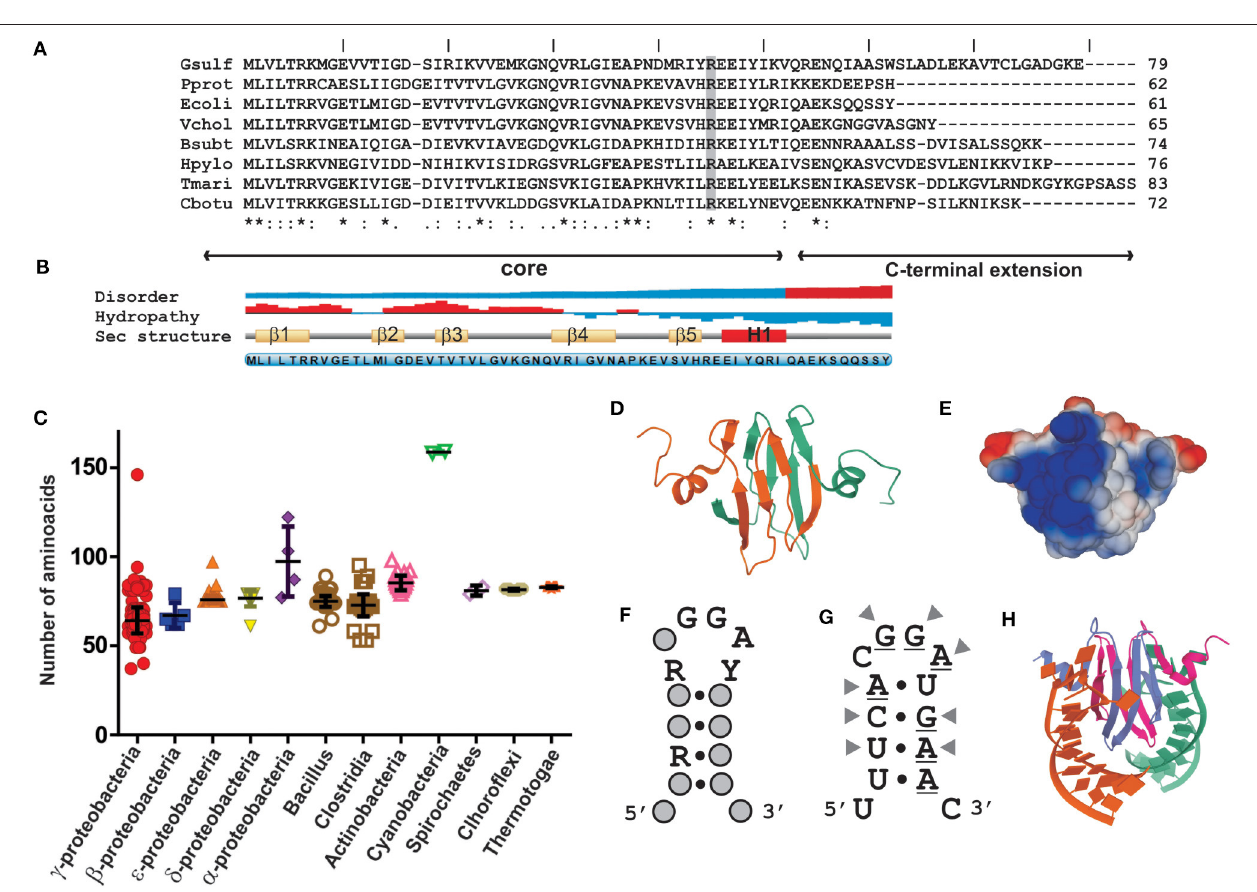
FIGURE 2 | Structural properties of CsrA proteins and their interaction with RNA sequence/structural motifs. (A) Primary sequence alignment of CsrA polypeptides from selected eubacterial species: Gsulf, Geobacter sulfurreducens ; Pprot, Pseudomonas protegens ; Ecoli, Escherichia coli ; Vchol, Vibrio cholerae ; Bsubt, Bacillus subtilis ; Hpylo, Helicobacter pylori ; Tmari, Thermotoga maritima ; Cbotu, Clostridium botulinum . The degree of residue conservation is indicated below each position of the alignment, as follows: an (*) indicates positions with a fully conserved residue; a (:) indicates conservation between amino acid groups of strongly similar biochemical properties; a (.) indicates conservation between groups of weakly similar properties. The residue shaded in gray (R) corresponds to the conserved arginine (R44 in E. coli CsrA) that is essential for the RNA-binding activity of CsrA proteins (Heeb et al., 2006; Schubert et al., 2007). The core region comprises the prototypical portion of the molecule that defines the CsrA fold, namely the β 1 β 2 β 3 β 4 β 5H1 arrangement; the C-terminal extension is highly variable among different taxa. (B) Secondary structure properties the E. coli CsrA polypeptide. The data was generated with the Protein feature view tool of the RCSB PDB server www.rcsb. org ( Berman et al., 2000). (C) The graph shows the length distribution of CsrA homologs within different eubacterial classes. For each group the average length (nr. of residues) ± standard deviation is indicated. (D) Ribbon diagram of the solution quaternary structure of the E. coli CsrA dimeric protein (PDB 1Y00). (E) Predicted charge distribution along the surface of the dimeric P. protegens RsmE protein (PDB 2JPP). (F) Consensus sequence/structural motif preferentially bound by E. coli CsrA in vivo , as detected following CLIP-Seq (adapted from Potts et al., 2019). R = G or A, Y = C or U. (G) Predicted secondary structure of the 14-mer encompassing the Shine-Dalgarno sequence (underlined nucleotides) of the hcnA 5 ′ -UTR from P. protegens strain CHA0, an experimentally validated target for the CsrA homolog protein RsmE (Lapouge et al., 2007; Schubert et al., 2007). The arrowheads point to the nucleotides contacted by specific RsmE residues in the complex shown in (H) (Schubert et al., 2007). (H) Ribbon diagram of the NMR solution structure of the RsmE– hcnA 5 ′ -UTR complex (PDB 2JPP). Each RNA binding site of the dimeric RsmE protein is interacting with one of two identical synthetic 20-mers containing the sequence-structural motif shown in (G)